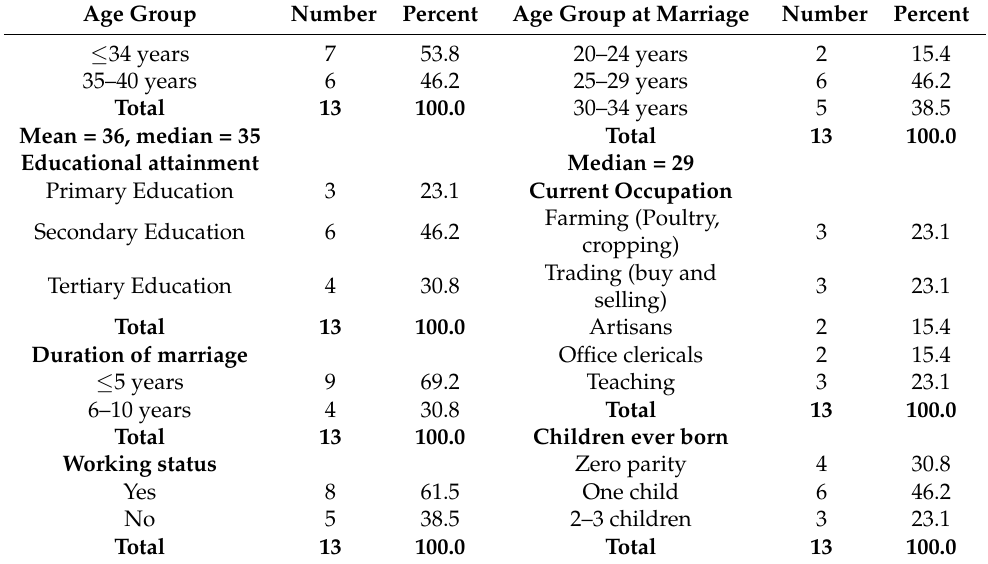
Table 1. Demographic profile of the